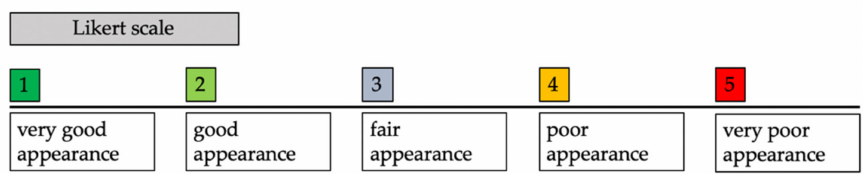
Figure 5. To display the Likert scale used for assessment of the cropped photographs.